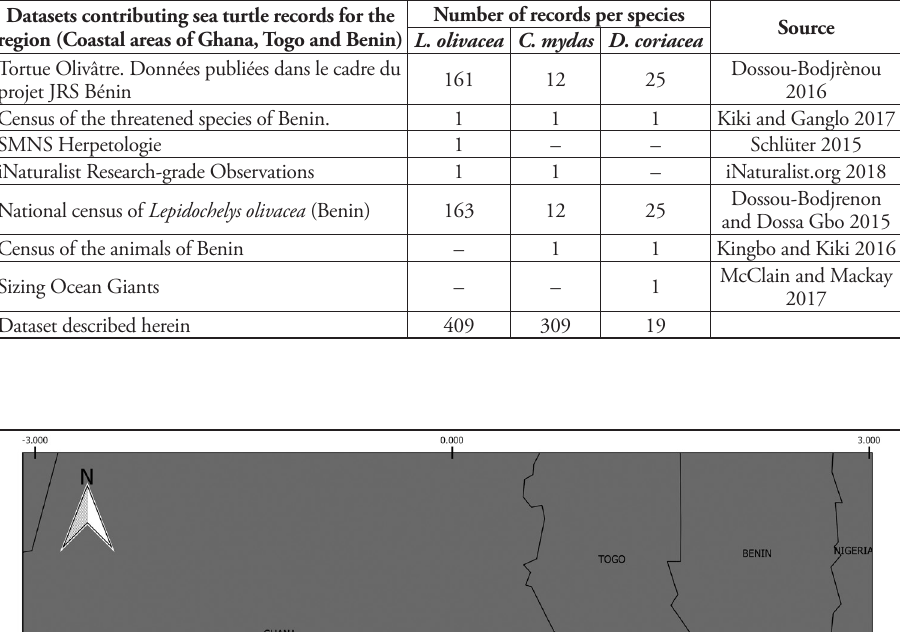
Table 1. Sea turtle records from the region per species and datasets as available from www.gbif.org (March 2018).